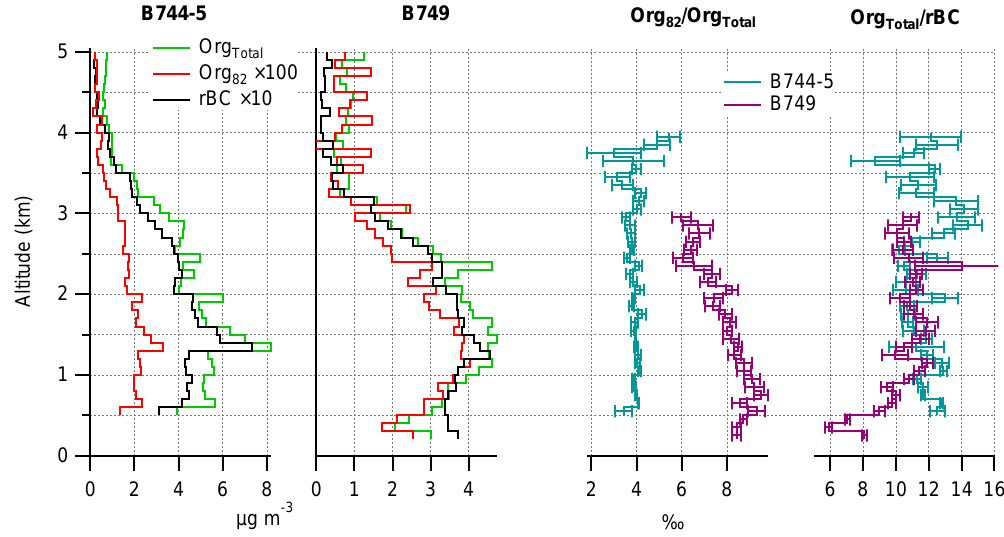
Figure 4. Comparison of mean vertical profiles of B744 and B745 with B749 for the carbonaceous species. The ratios are taken of the average values and the error bars correspond to standard errors. Ratios for higher altitudes showed high degree of variability (and associated errors) and have been omitted for